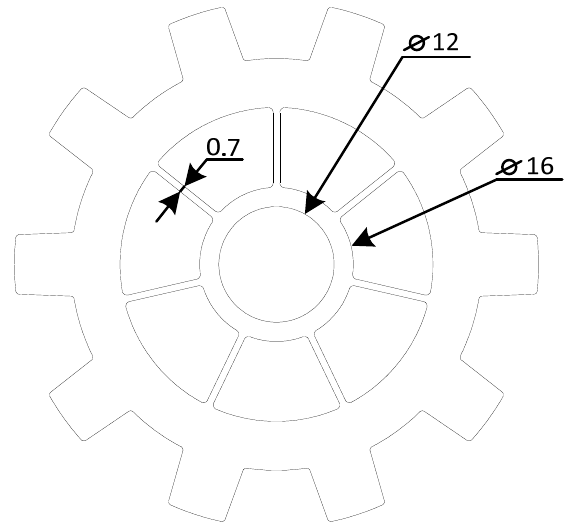
Figure 25. Modified rotor geometry for prototyping.